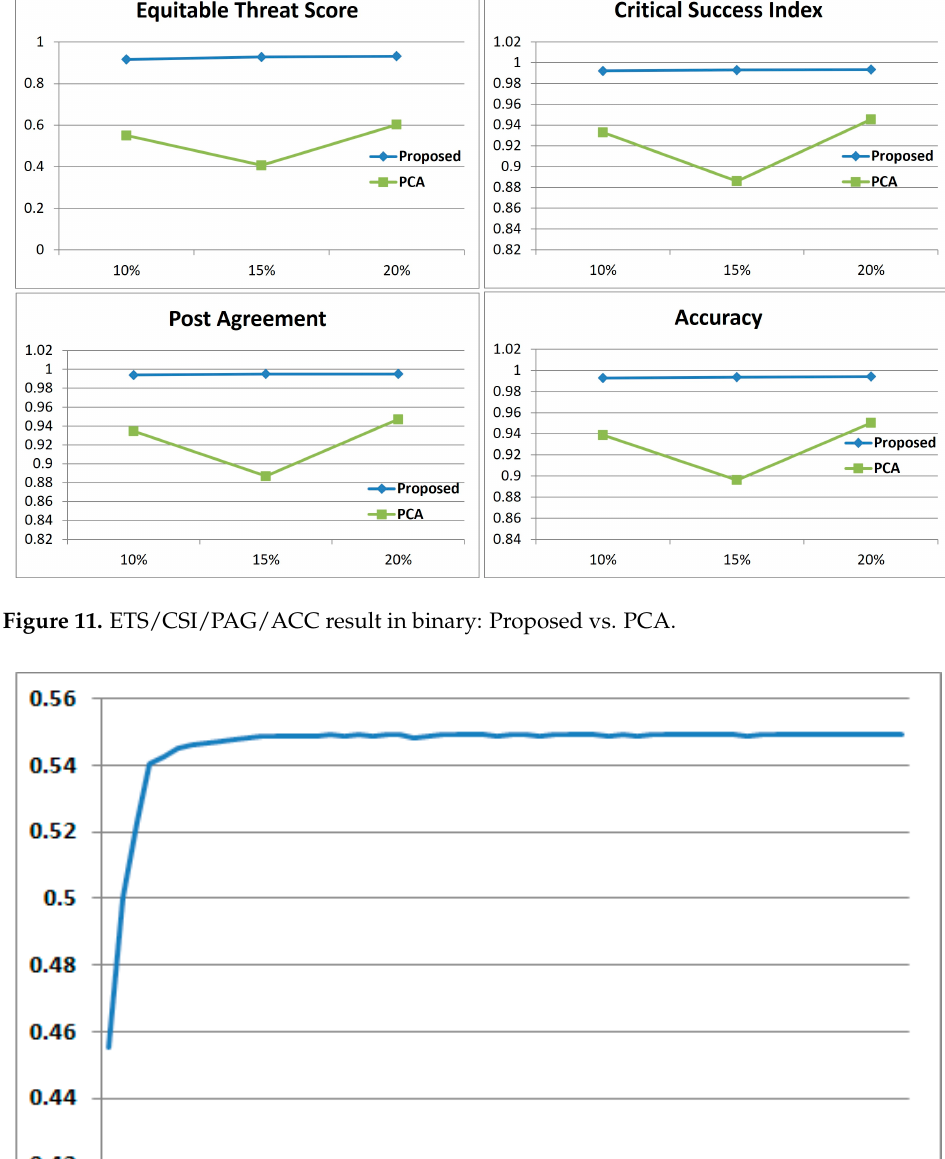
Figure 10. ETS/CSI/PAG/ACC result in binary: proposed vs wrapper-DR.